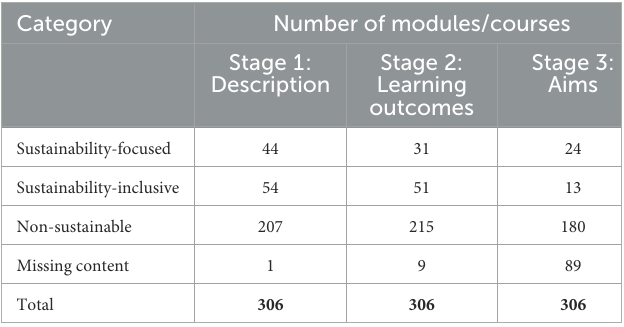
TABLE 5 Manual associations of 306 modules/courses per sustainability category for all[[Inline Image]]